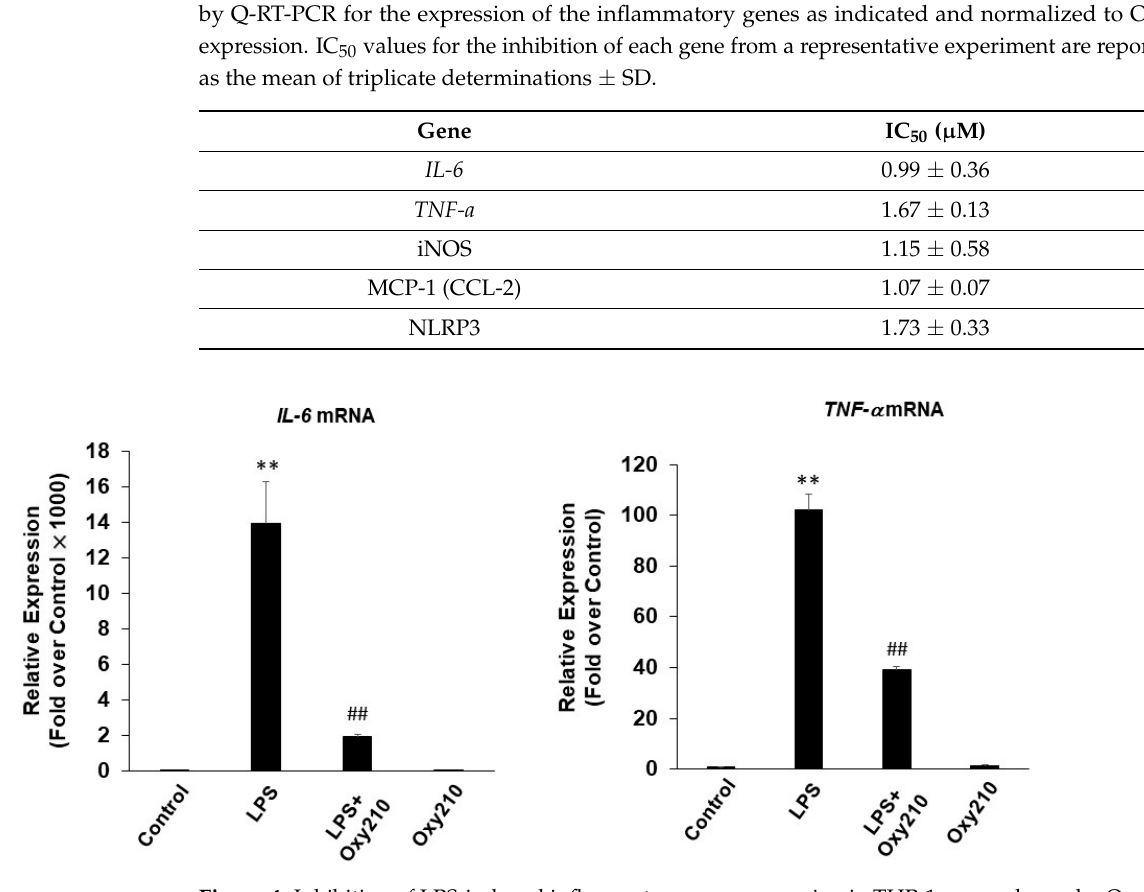
Figure 4. Inhibition of LPS-induced inflammatory gene expression in THP-1 macrophages by Oxy210. THP-1 cells were pretreated with Oxy210 (5 µ M) in RPMI containing 0.1% FBS for 24 h followed by the addition of LPS (100 ng/mL) in the absence or presence of Oxy210 (5 µ M). After 24 h, RNA was extracted and analyzed by Q-RT-PCR for the expression of inflammatory genes as indicated and normalized to GAPDH expression. Data from a representative experiment are reported as the mean of triplicate determinations ± SD (** p < 0.01 vs. control; ## p < 0.01 vs. LPS). Table 1. Inhibition of inflammatory cytokine expression by Oxy210 in RAW264.7 macrophages. Cells were pretreated for 24 h with serial dilutions of Oxy210 (0.5, 1, 2.5, 5, 10 μ M) in DMEM con- taining 0.1% FBS followed by the addition of LPS (25 ng/mL) in the absence or presence of Oxy210 at the same concentrations as that used in pretreatment. After 24 h, RNA was extracted and analyzed by Q-RT-PCR for the expression of the inflammatory genes as indicated and normalized to Oaz1 expression. IC 50 values for the inhibition of each gene from a representative experiment are reported as the mean of triplicate determinations ± SD. Gene IC 50 ( μ M ) IL-6 0.99 ± 0.36 TNF-a 1.67 ± 0.13 iNOS 1.15 ± 0.58 MCP-1 (CCL-2) 1.07 ± 0.07 NLRP3 1.73 ± 0.33 Depending on the structure, chemical properties, and biological context, oxysterols can be activators or inhibitors of cellular signaling. We had previously demonstrated that two related naturally occurring oxysterols, 20( S )-hydroxycholesterol (20( S )-OHC) and 20 α ,22( R )-dihydroxycholesterol (Oxy16) (Figure 5A) can activate or inhibit Hh signaling, respectively, in mesenchymal cells [54–56]. While 20( S )-OHC stimulates the pathway via allosteric activation of Smoothened (Smo), Oxy16, which does not bind to Smo, inhibits the pathway downstream of Smo in a Smo-independent manner [34,57]. We have further shown that these opposing biological activities correlate with rigid conformational prop- erties exhibited by 20( S )-OHC and Oxy16 which either enable or prevent Smo binding [36]. Smo binders, such as cholesterol and 20( S )-OHC, prefer an extended conformation of the sterol side chain, both in the crystalline state and when bound to the sterol binding pocket of the Smo protein (Figure 5A) [58–60]. By contrast, Oxy16 departs from the